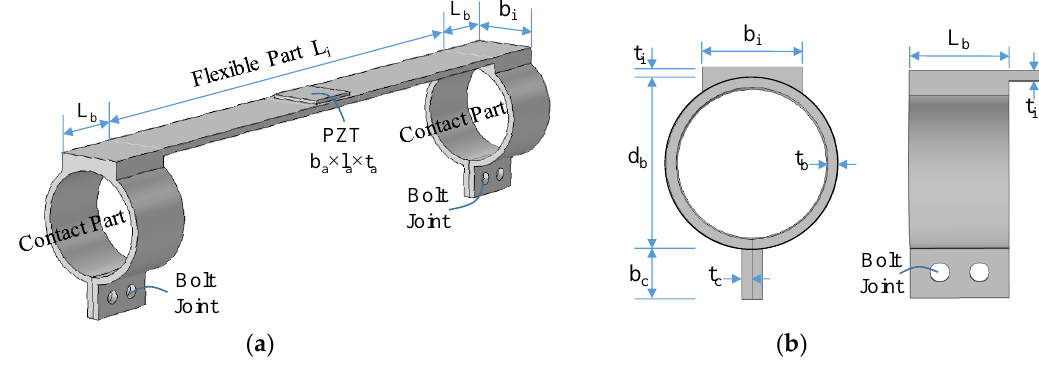
Figure 3. Design of wearable piezoelectric interface for cylindrical structure: ( a ) wearable lead zirconate titanate (PZT) interface; ( b ) contact part.